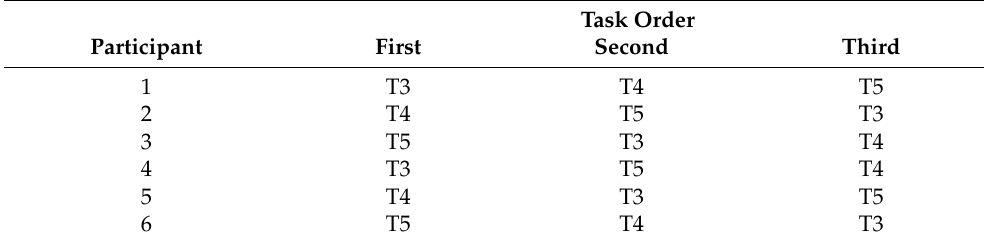
Table 6. Task order based on a balanced Latin square.